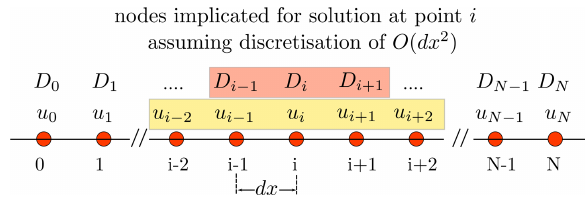
Figure 4. Grid and finite-difference stencil for the solution of the flexure equation with variable elastic thickness, showing the grid elements involved in the discretisation of the problem pertaining to the value of u i at grid node i . Variation in D (due to variation in h ) at any node i is achieved across grid nodes i − 1 ,i,i + 1. Hence, for abrupt changes in D and h , the value of h must be adjusted for at least three adjacent nodes in order to take full effect. The discreti- sation of the derivative of u requires the five nodes i − 2 ,...,i + 2. Grid spacing d x gives the problem a physical